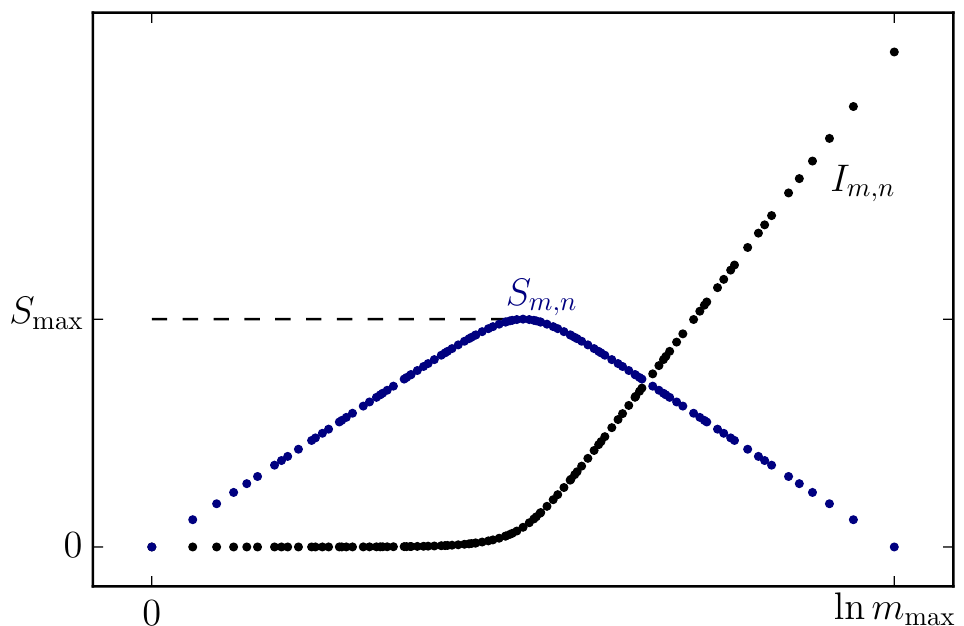
Figure 4. Page curve, representing the entanglement between matter modes inside the BH and matter modes of the radiation leaving the BH (in this picture there is no explicit reference to the degrees of freedom related to space) vs. the log of the dimension m of the Hilbert space of the radiation, obtained in [81,82]. The point ln m = 0 corresponds to the initial mass of the BH, M = M 0 . Indeed, m = 1 means that only the vacuum state populates the radiation subsystem of the Hilbert space, at the start of the evaporation. On the other hand, m max corresponds a fully evaporated BH, M = 0. Figure taken from